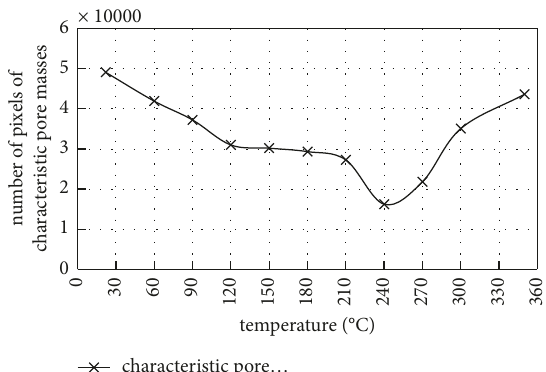
Figure 8: The graph for the identification of pore pixels number of fine sandstone samples with the increasing